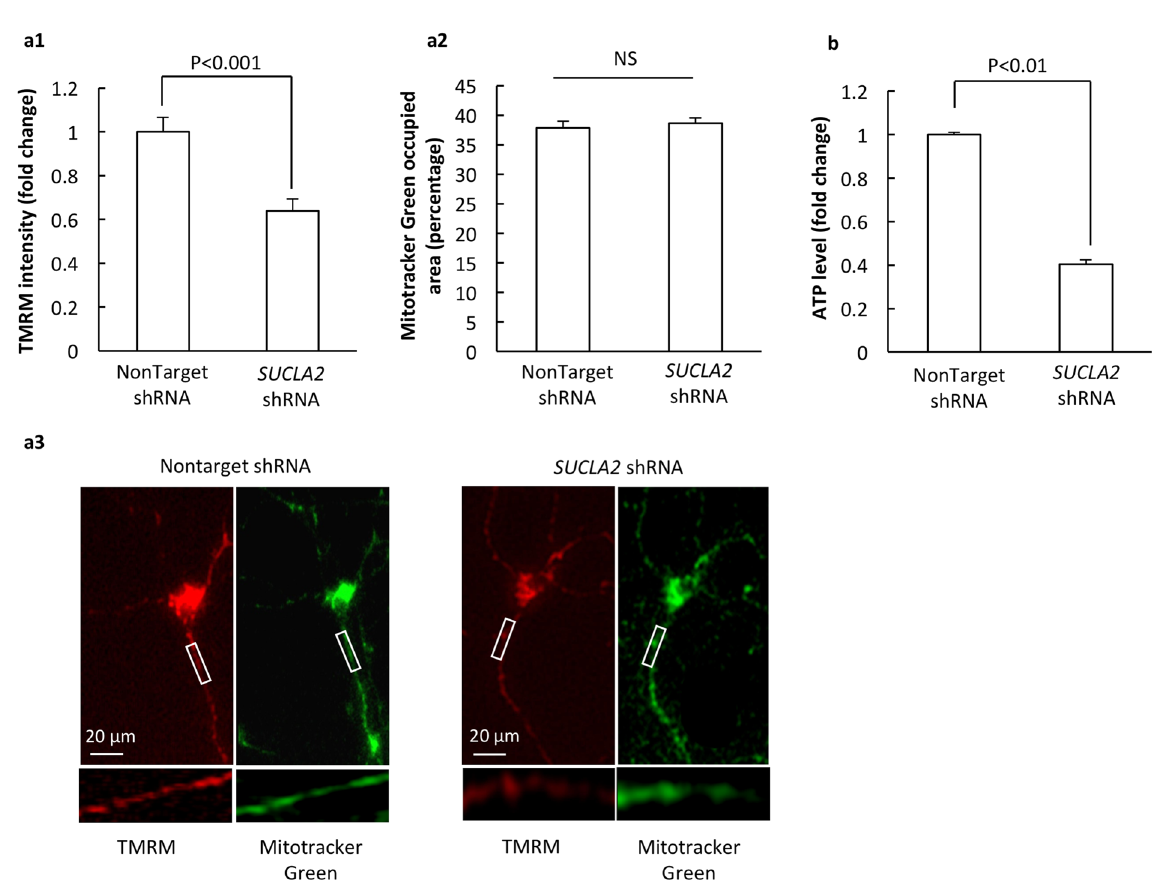
Figure 2. Loss of SCS A- β suppresses mitochondrial function. SCS A- β knockdown neurons showed decreased mitochondrial membrane potential ( a1 ) and ATP content ( b ); while there was no significant difference in dendritic mitochondrial content between the two groups of neurons ( a2 ). ( a3 ) are representative images of TMRM (red) and Mitotracker Green (green) staining. The data were collected from 3 independent experiments. Scale bar = 20 µ